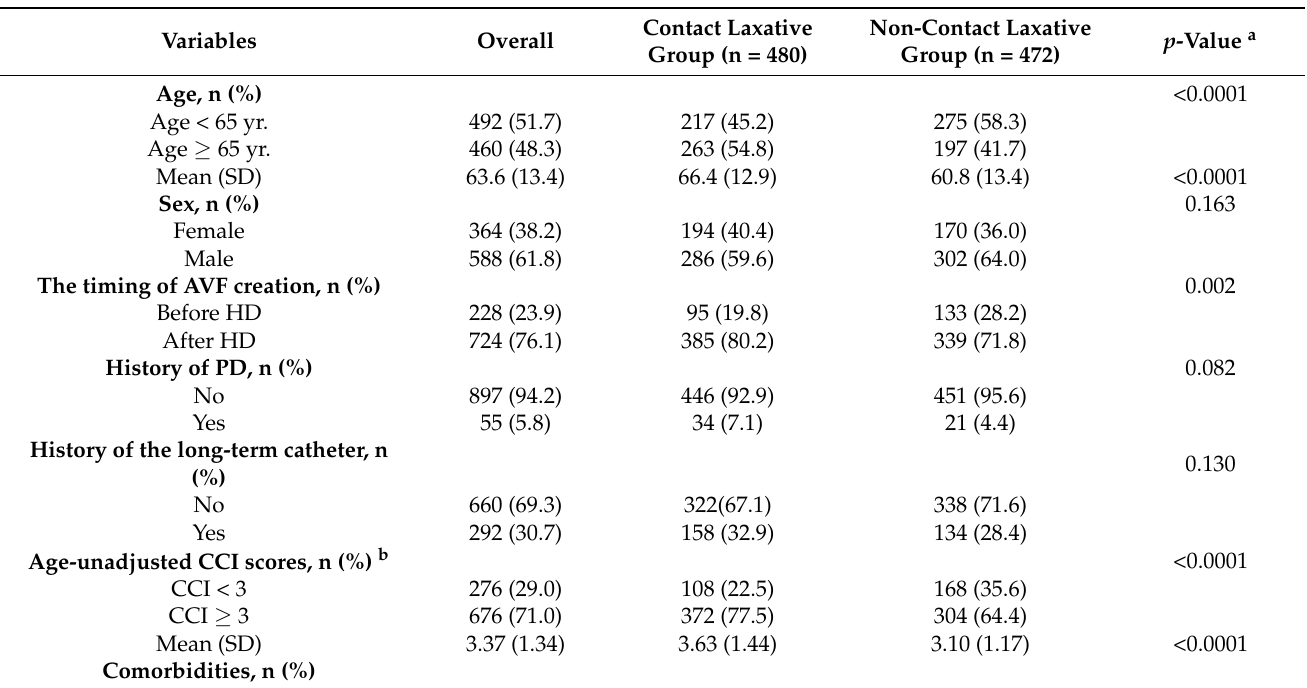
Table 1. Patient characteristics of the study